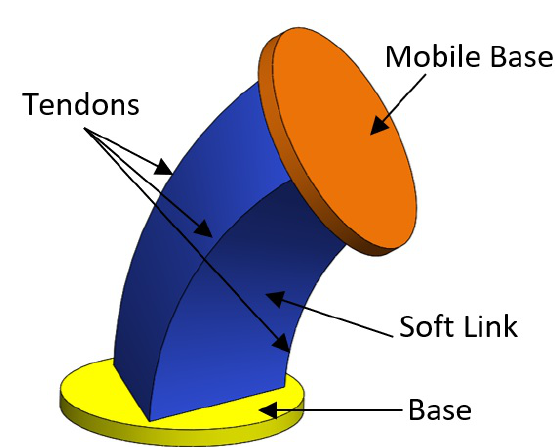
Figure 2. Conceptual design of the joint with its components: base, continuous soft axis, tendons for performance and tip (mobile base) of the soft